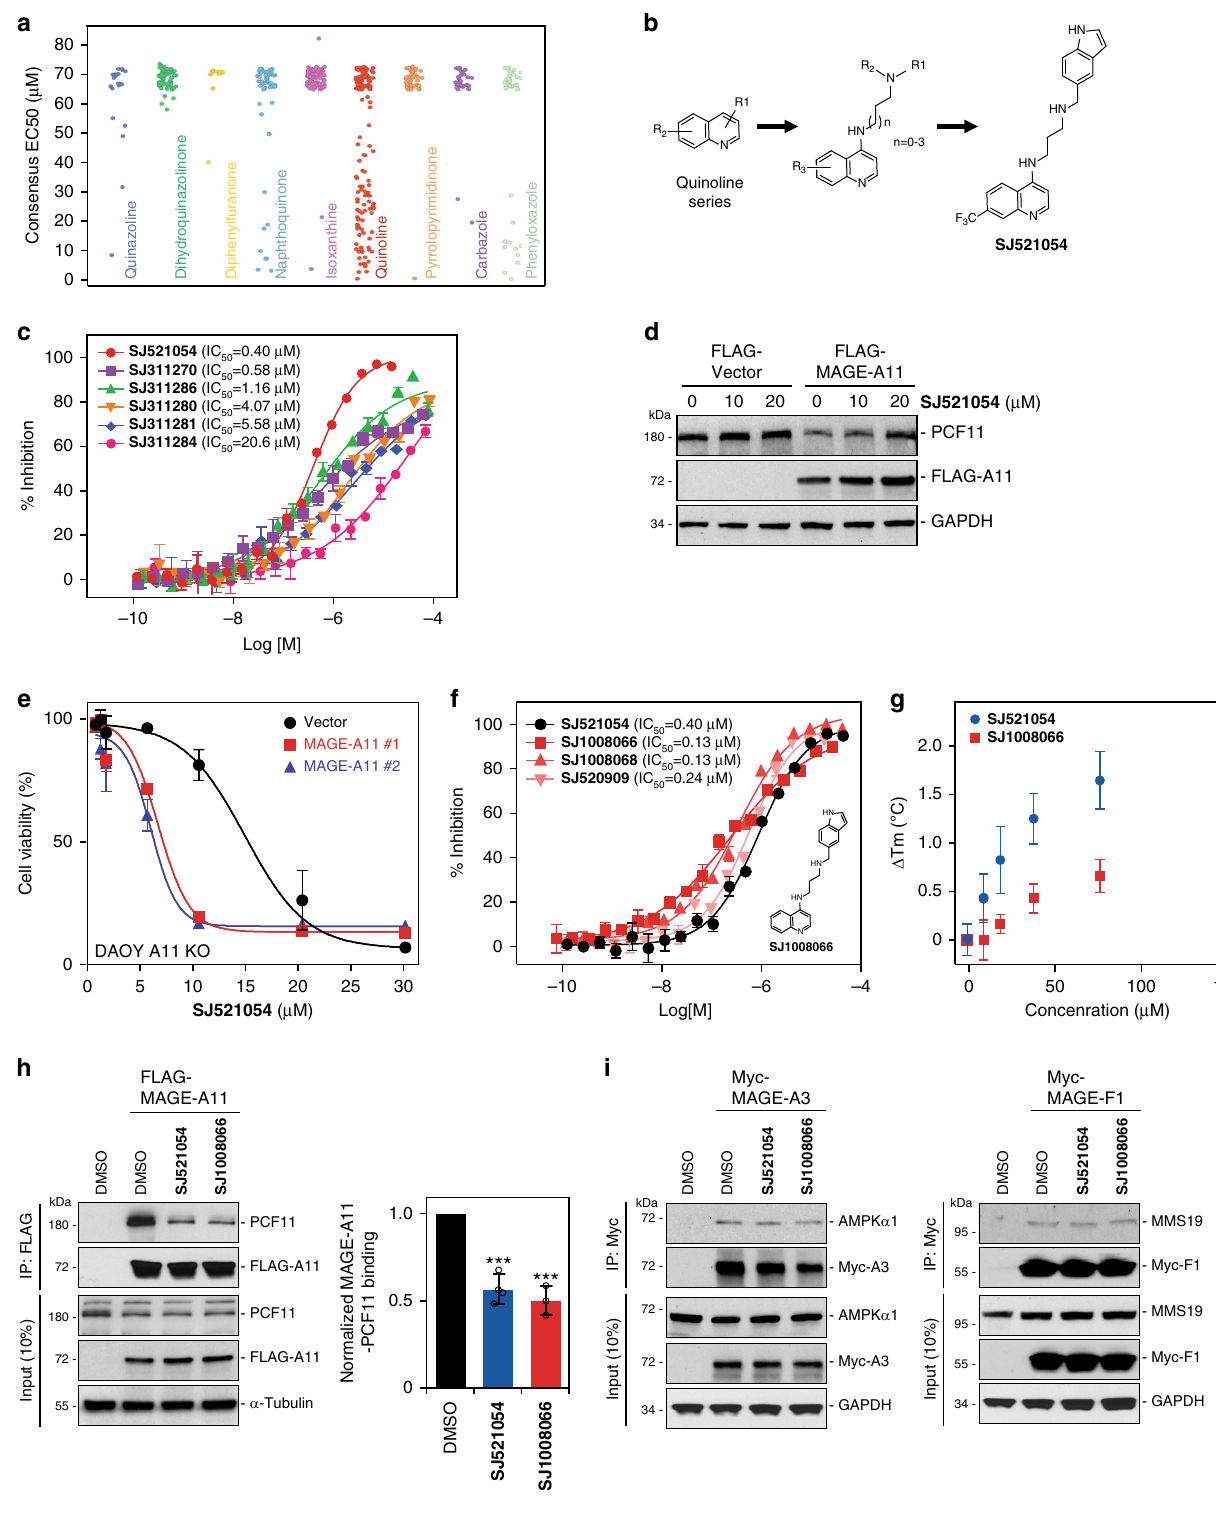
Methods Cell culture and stable cell lines . HEK293FT, HeLa and DAOY cells were grown in DMEM (Gibco) supplemented with 10% (v/v) FBS (Hyclone), 2 mM L -gluta- mine, 100 units/ml penicillin, 100 units/ml streptomycin, and 0.25 mg/ml amphotericin B (Invitrogen). HEK293FT and DAOY cells were transfected with either HA-FLAG-vector, FLAG-MAGE-A11 wild-type or SBC mutants using Effectene (QIAGEN) according to the manufacturer ’ s protocol in 6cm 2 plates. After 48h, cells were selected with 1µg/ml puromycin (Sigma) over 2 weeks.